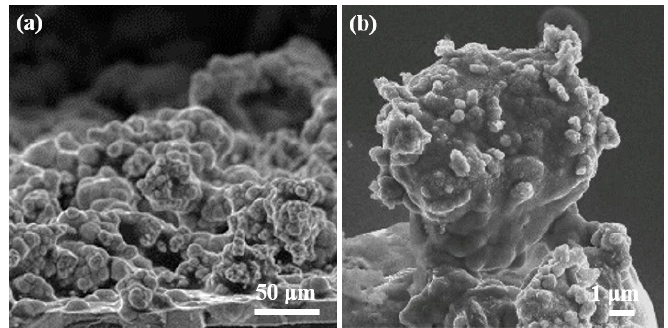
Figure 11. ( a – e ) Photographs illustrating water droplet does not adhere to the Ni–Co/WS 2 7.1 wt.% surface: ( a ) a needle with suspended water droplet is set on the top of the Ni–Co/WS 2 coating; ( b ) the water droplet touches the surface of the coating with a low approaching velocity; ( c ) the water droplet become rounder as the needle further approach; ( d ) the water droplet is deformed heavily when the needle is separating from surface; ( e ) the water droplet is away from the coating after separation.